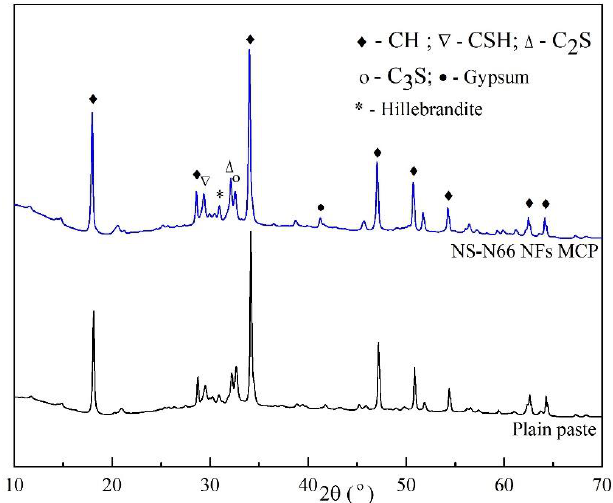
Figure 5. XRD patterns of the hardened cement pastes.